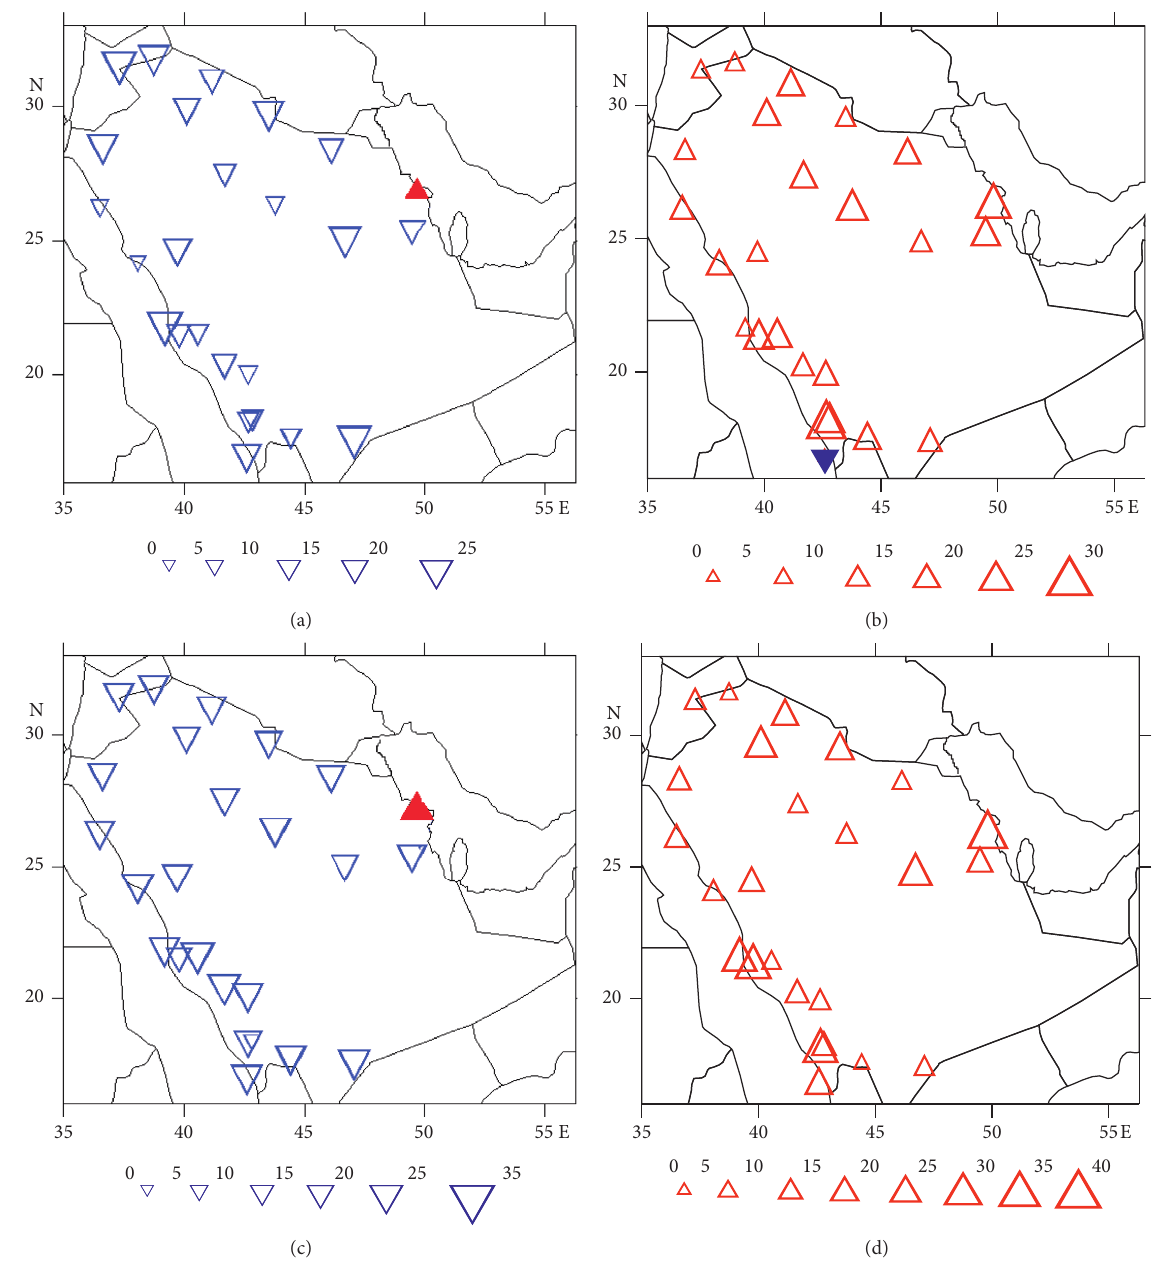
Figure 10: Spatial distribution of linear trends (days per decade) in (a) cold days (TX10p), (b) warm days (TX90p), (c) cold nights (TN10p), and (d) warm nights (TN90p) for the period 1978–2019. The scales for linear trends are not the same for all